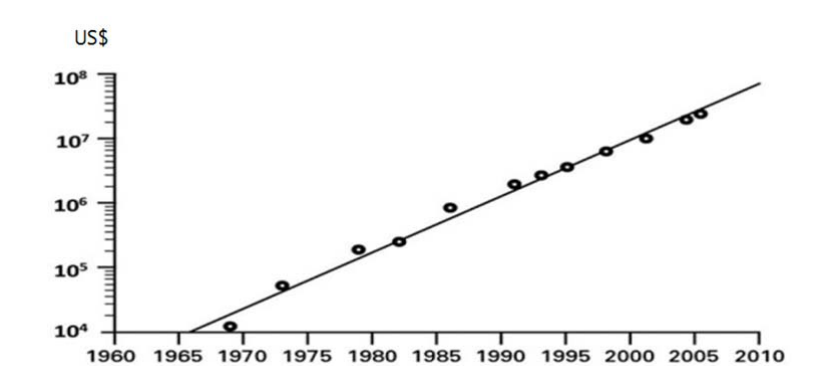
Figure 3. The exponential growth of the cost of lithographic equipment since 1966